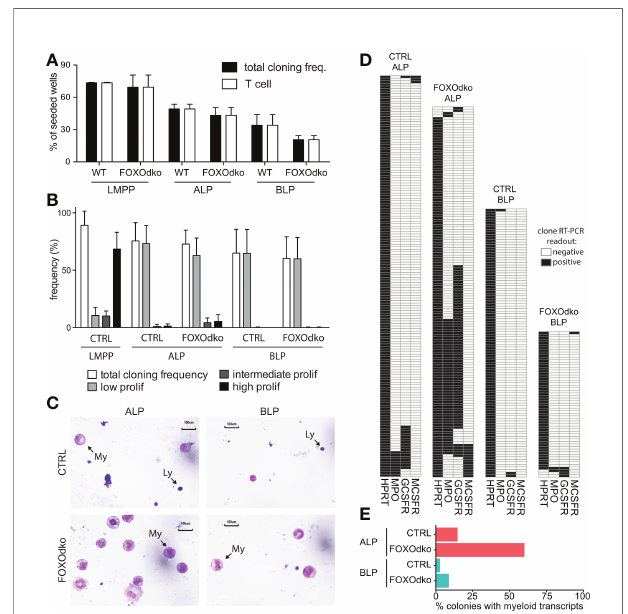
FIGURE 7 | Loss of FOXO alleviates myeloid restriction in CLPs. (A) Frequency of single progenitors generating clones and T-cells (CD90.2/Thy1.2 + CD25 + ) on OP9-DL1. (B) Frequency of single CLPs capable of generating colonies of the indicated size under myeloid growth conditions. Data is from seven independent experiments. (C) Morphology of cells derived from CLPs under myeloid conditions. Arrows indicate lymphoid (Ly) and myeloid (My) cells. (D) Heatmaps of gene expression in single-CLP derived colonies detected by multiplex RT- PCR. Data is from two independent experiments. (E) Percentage of colonies in panel D expressing myeloid transcripts ( Mpo , Gcsfr and/or Mcsfr